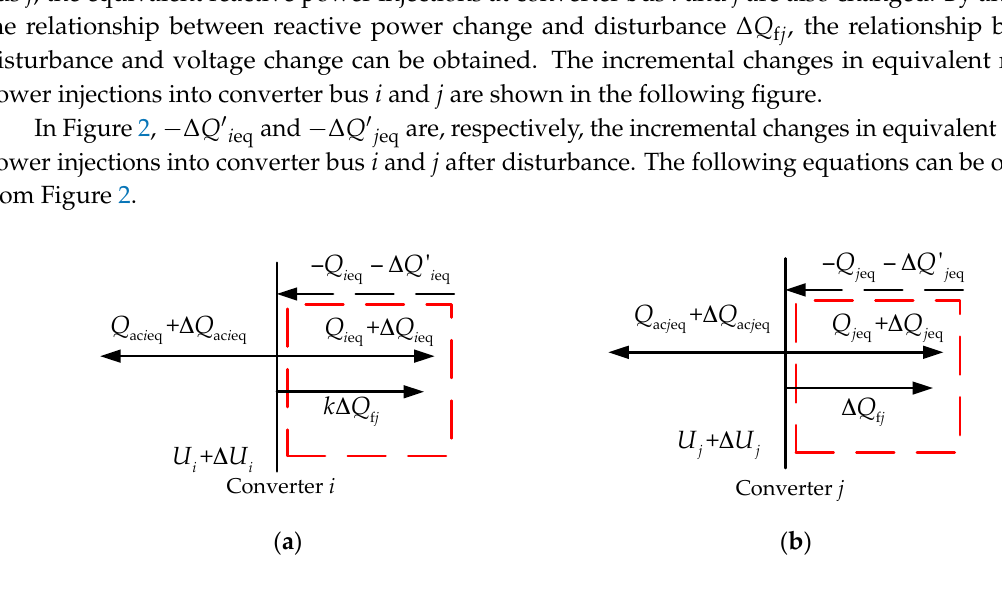
Figure 2. Schematic diagram of the change of reactive power at converter bus. ( a ) the change of reactive power at converter bus i ; ( b ) the change of reactive power at converter bus j .